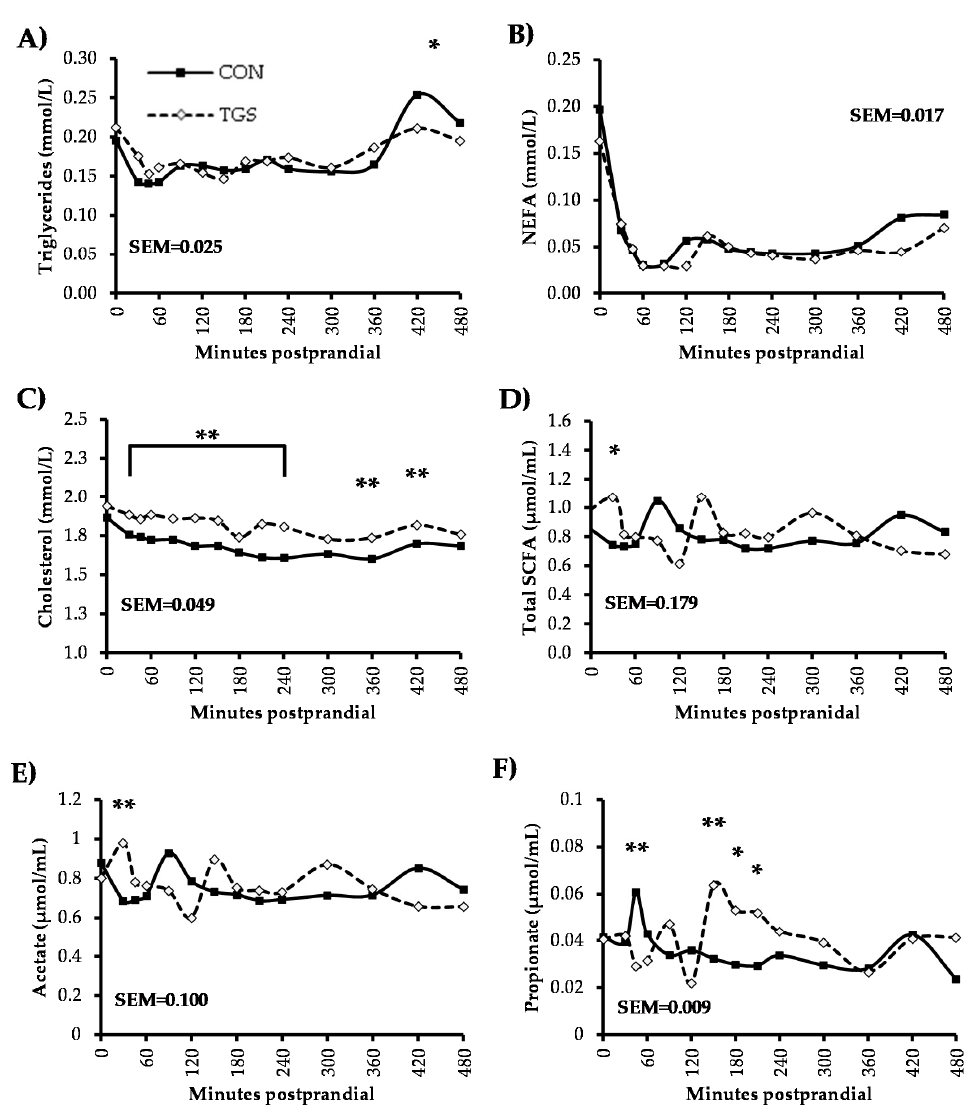
Figure 2. Triglycerides ( A ); non ‐ esterified fatty acids (NEFA; B ); cholesterol ( C ); total short ‐ chain fatty acids (SCFA; D ); acetate ( E ); and propionate ( F ) concentrations in blood serum from pigs fed control (CON) or transglycosylated starch (TGS) diet. Data are presented as least square means; control diet n = 6, TGS diet n = 7. ** CON and TGS diet differ in blood serum or plasma concentrations, p < 0.05; * CON and TGS diet tend to differ in blood serum or plasma concentrations, 0.05 < p ≤